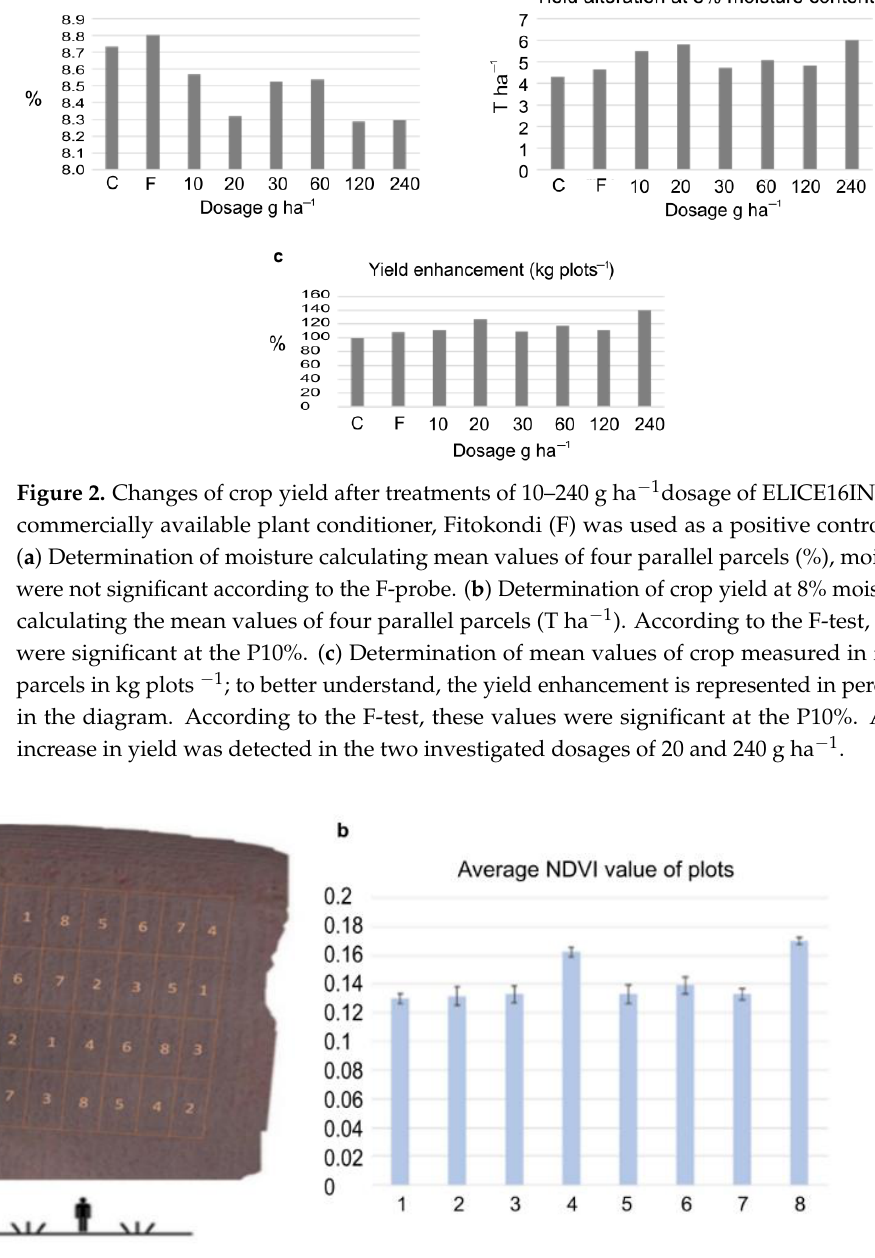
Figure 3. The agro-drone record was captured with a near-infrared camera during the experimental parcels. ( a ) Placement of parcels are: (1) control without treatment; (2) positive control treated with Fitokondi; (3) 10 g ha −1 ; (4) 20 g ha −1 ; (5) 30 g ha −1 ; (6) 60 g ha −1 ; (7) 120 g ha −1 ; (8) 240 g ha −1 ELICE16INDURES (GPS coordinates: 47 deg37 ′ 58.30 ″ N, 18 deg15 ′ 54.36 ″ E). ( b ) Average NDVI values of plots calculated from near-infrared channels of Agro-drone. The highest NDVI values were shown after the low and high (20 and 240 g ha −1 ) dosages of ELICE16INDURES treatment.